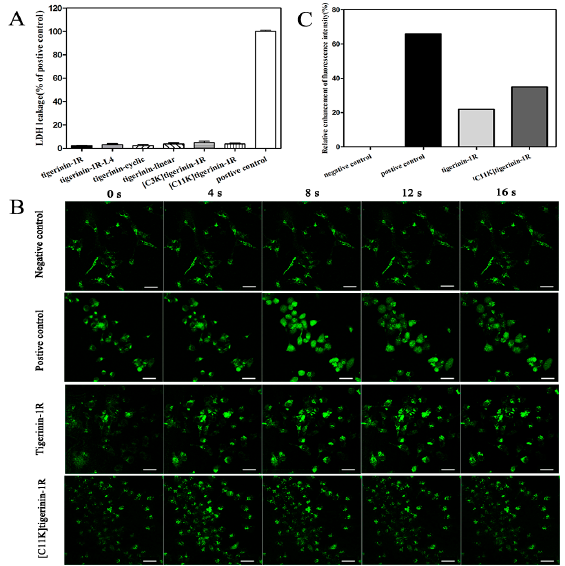
Figure 4. Mechanism of stimulation of insulin release. ( A ) Lactate dehydrogenase leakage after incubation with 10 − 5 M peptide in the presence of 2.8 mM glucose for 1 h. 1% Triton X-100 served as the positive control. The assays were repeated in triplicates. ( B ) INS-1 cells were loaded with 5 μ M Fluo-3AM. [Ca 2+ ] i indicated by the fluorescence intensity was measured. The fluorescence was excited at 480 nm at 4 s intervals and detected at 515 nm. Glucose (2.8 mM) alone (negative control), 30 mM KCl (positive control), or peptides of 10 − 5 M supplemented with 2.8 mM glucose were added, respectively. Scale bar = 100 μ m and refers to all panels. ( C ) The relative enhancement of fluorescence intensity was calculated as (the maximum arithmetic mean intensity value − the initial arithmetic mean intensity value)/the initial arithmetic mean intensity value × 100%. The arithmetic mean intensity values were quantitated using ZEN 2012 image software (CarlZeiss, Oberkochen, Germany).